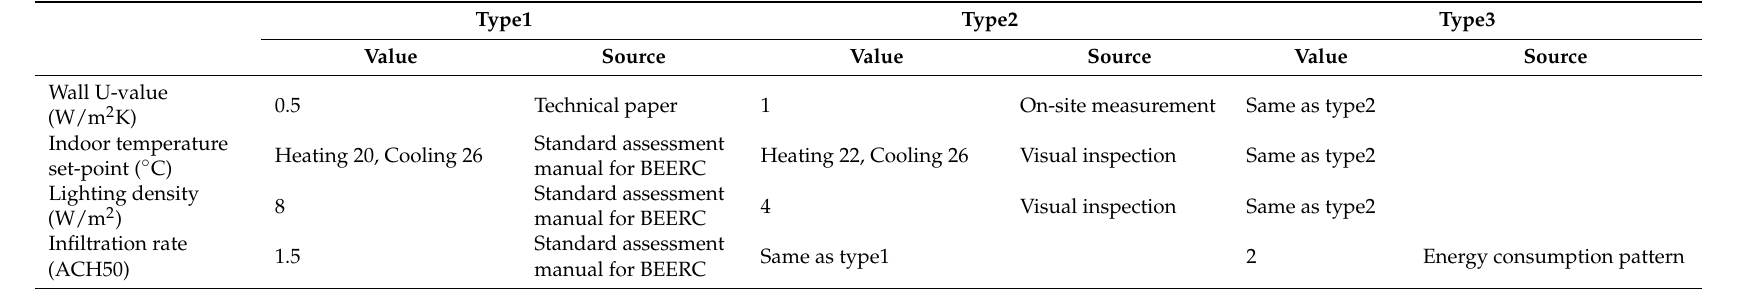
Table 8. Investigated and estimated parameters of UB1 according to the assessment